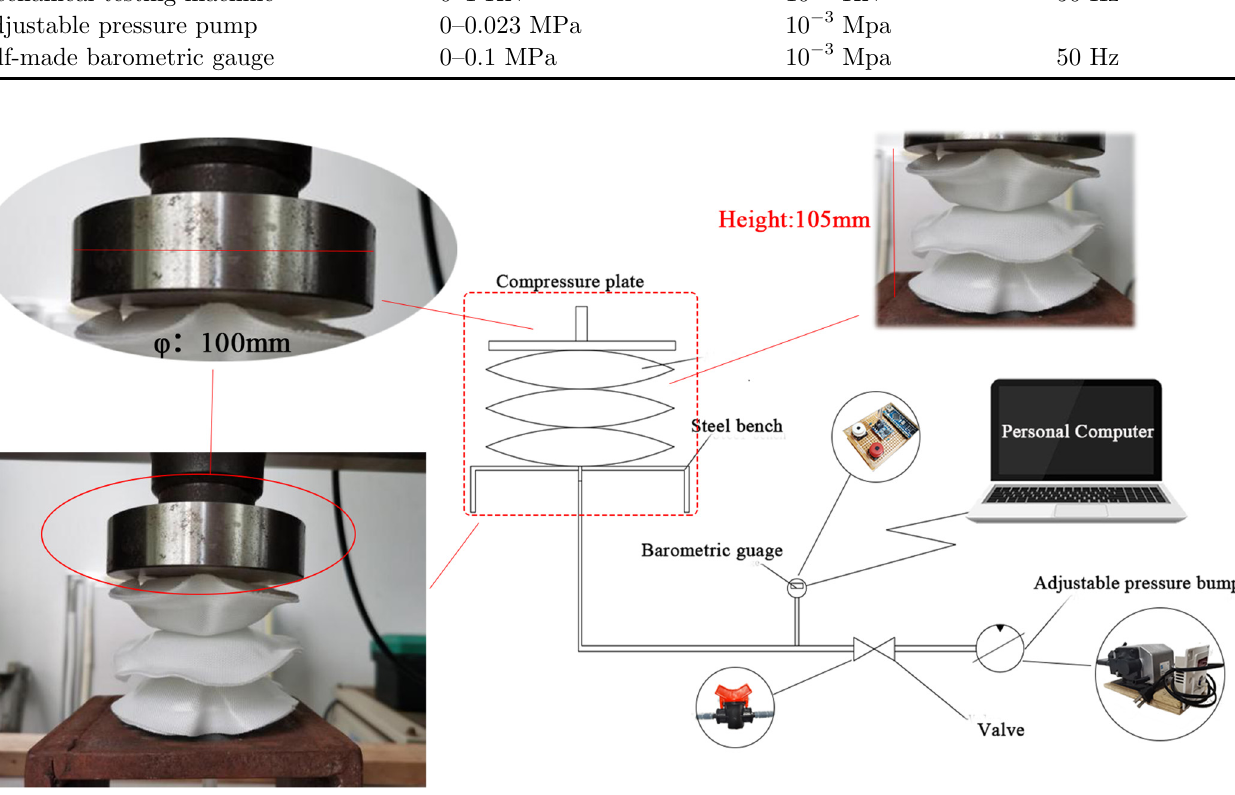
Fig. 2. Connection diagram of